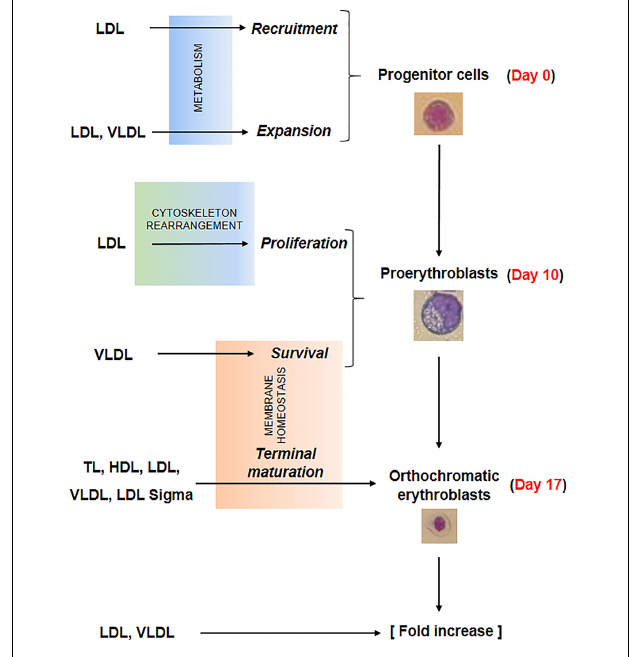
FIGURE 7 | Summary of the effects exerted by the lipoprotein fractions investigated in this study on erythroid differentiation. Recruitment and expansion in liquid culture of the erythroid progenitor cells was improved by LDL and LDL/VLDL, respectively, probably by mechanisms targeting cell metabolism. LDL increased also the proliferation of days 10 proerythroblasts, probably by mechanisms involving rearrangement of the cytoskeleton. Lastly the survival and terminal maturation of the proerythroblasts was favored by LDL and by all the lipoprotein fractions, respectively through mechanisms involving improvement of membrane homeostasis. All these biological effects contributed to the greater erythroid expansion observed in HEMA def supplemented with lipoproteins, expecially when the lipoproteins were represented by LDL and